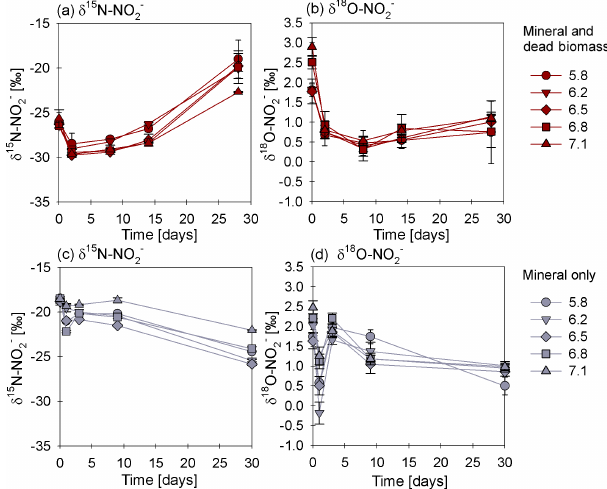
Figure 6. Site preference (SP; a, c ) and δ 15 N bulk (b, d) values of measured in N 2 O produced in mineral and dead biomass amended (red) and 2 mineral-only (grey) experiments. For a pH of 6.5, the final SP value (a) is missing due to analytical problems (overly large sample peak areas). The standard error calculated from biological replicates ( n = 3 or 2) is represented by the error